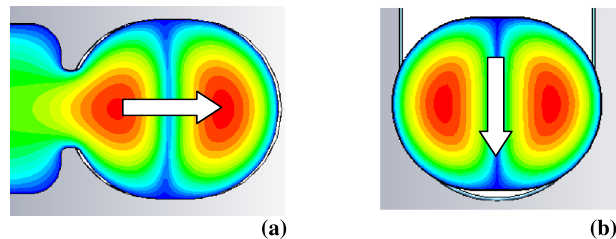
coupled horizon- 10